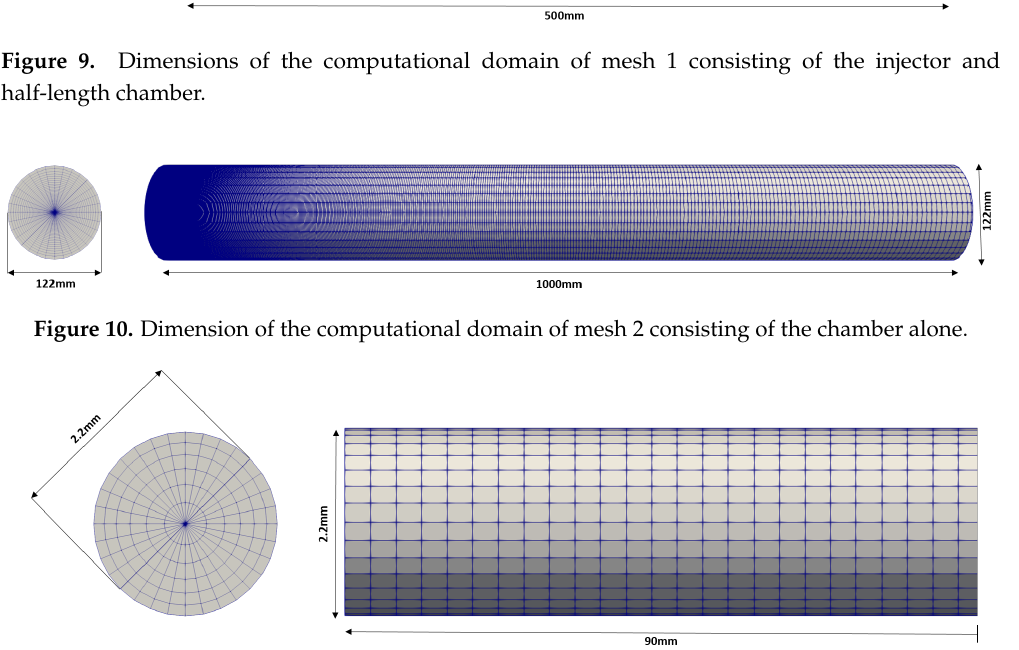
Figure 11. Discretisation of the injector in mesh 1. Please note that the figure only represents a small portion of the injector in the axial direction.